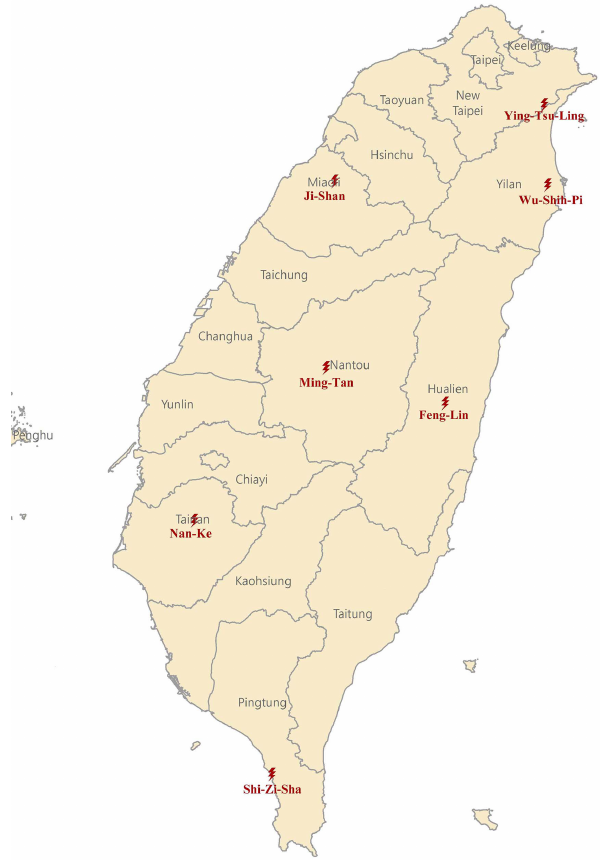
Figure 1. Map of Taiwan showing the location of the sensors and the urban area of Taipei County.